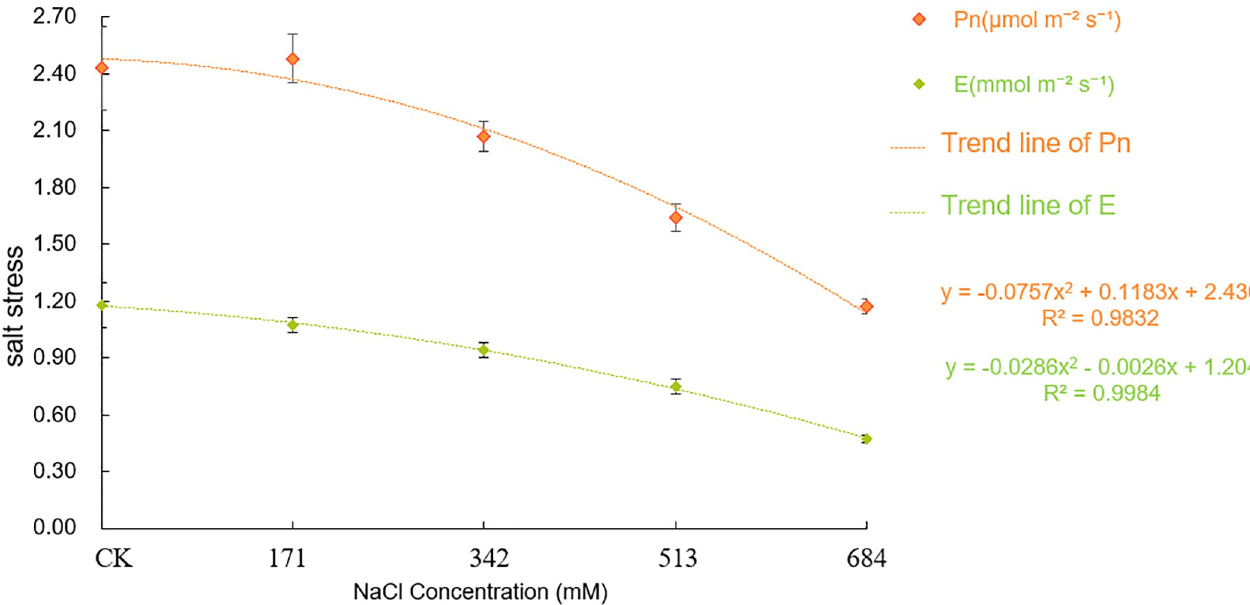
PLOS ONE | https://doi.org/10.1371/journal.pone.0260086 November18,